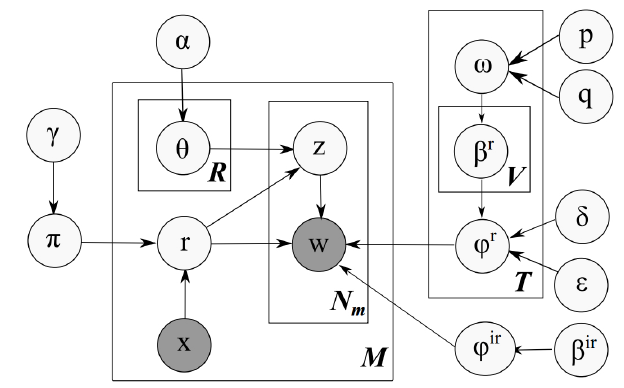
Figure 1. The graphical model of